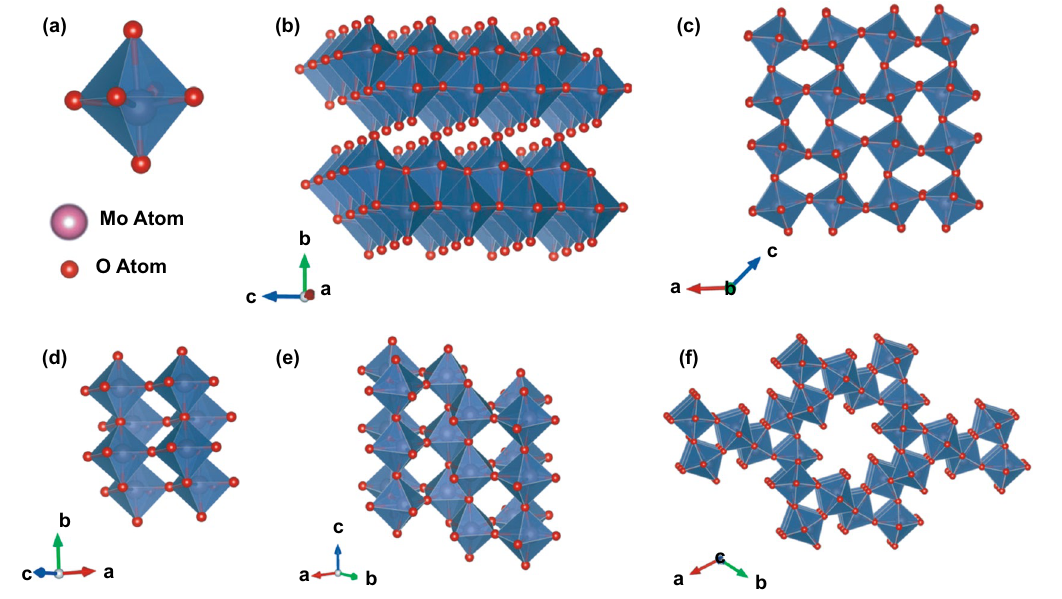
Fig. 1 a MoO 6 octahedra in the thermodynamically stable α -MoO 3 phases. b Orthorhombic α -MoO 3 with a layered structure. c Metastable monoclinic β -MoO